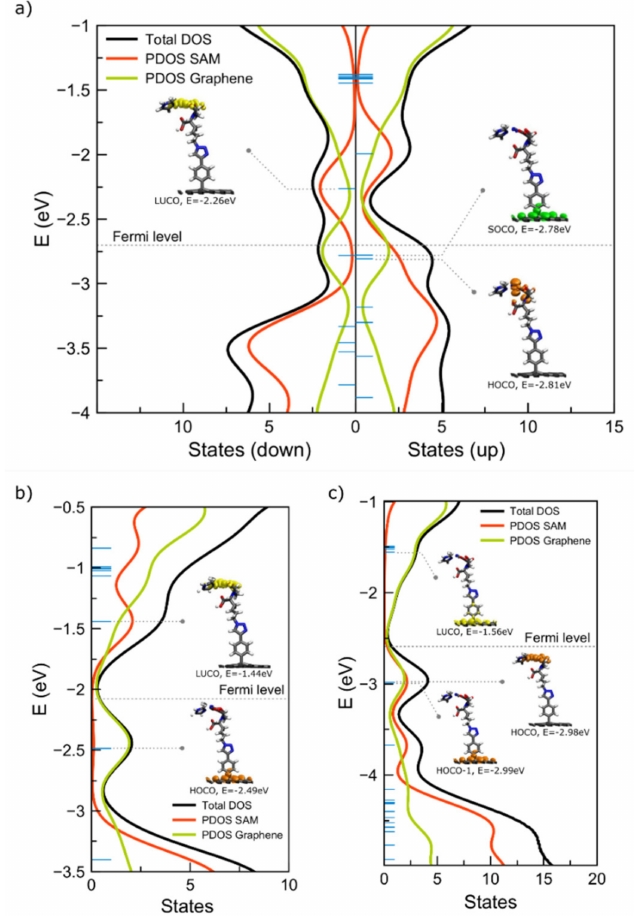
Figure 3. Total DOS projected over onto corresponding fragments for the Ni-1DB ( a ), Co-1DB ( b ) and Cu-1DB ( c ) interfaces. Eigenvalues are marked with horizontal blue lines and the Fermi level is indicated by a dotted grey line. HOCO (orange), SOCO (green) and LUCO (yellow) are marked and connected to corresponding